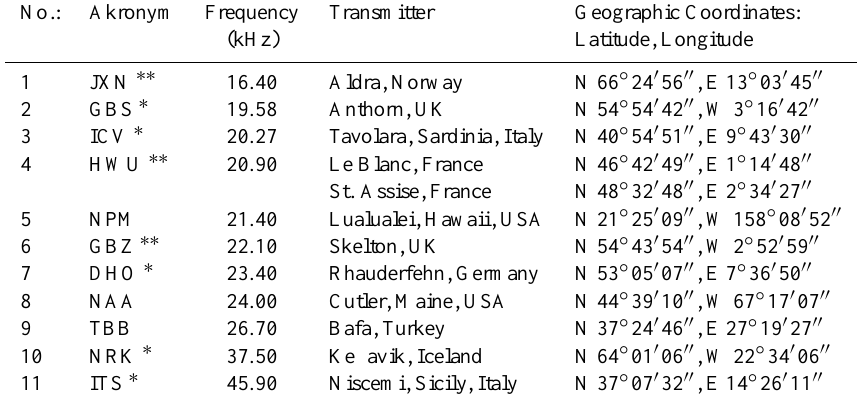
Table 2. VLF transmitters received at station Graz, two of them are above the strict definition of the VLF frequency range from 3–30 kHz. No.: Akronym Frequency Transmitter Geographic Coordinates: (kHz) Latitude,